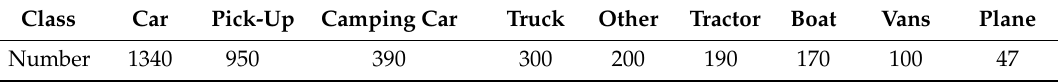
Table 1. Number of each vehicle category in VEDAI dataset.